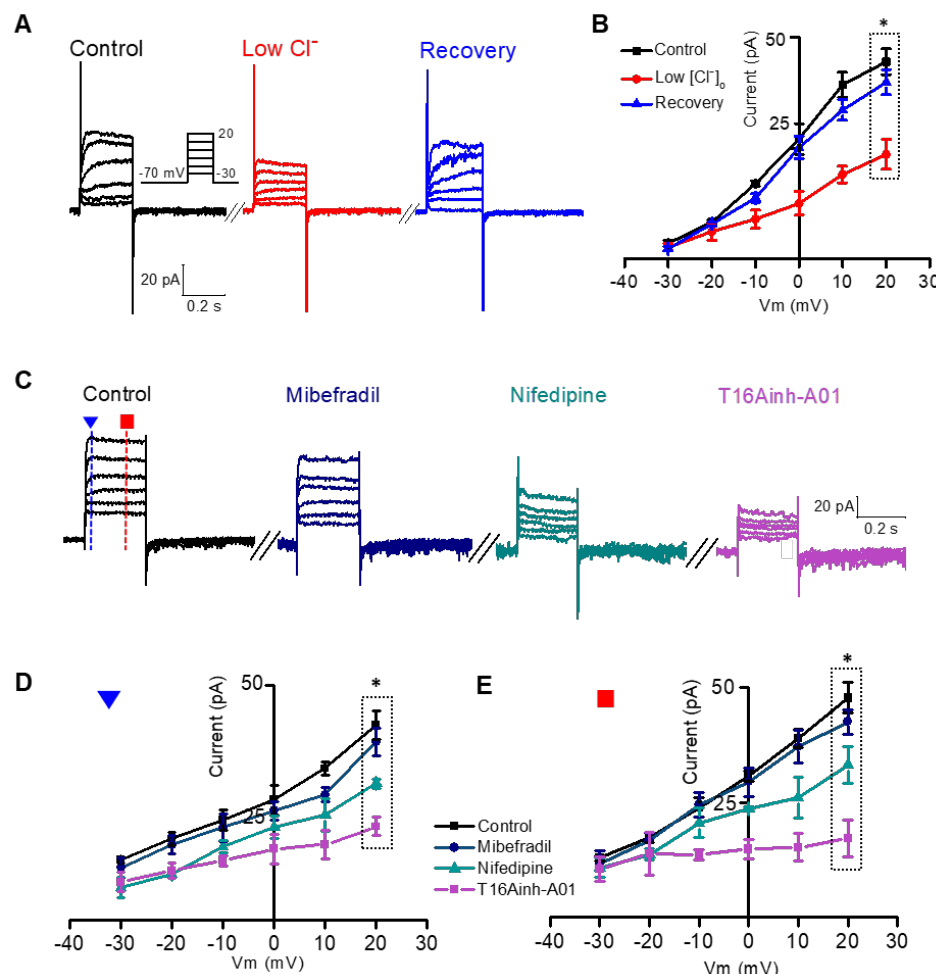
Figure 2. Isolation of the voltage-dependent component of ANO1 in rod bipolar cells. Isolation of the outwardly rectifying ANO1 component with strong voltage dependence. ( A ) In a single rod bipolar cell lacking I tail , a family of whole-cell currents was serially recorded to monitor the changes in outward current as [Cl − ] o changes. First, voltage-clamp (−30 to 20 mV for 250 ms) was performed under 140 mM of [Cl − ] o (black). Next, a family of whole-cell current was recorded after the extracellular replacement of Cl − with 100 mM gluconate (red) and then back to the control (blue). ( B ) For each of the three cases, the outward current (mean amplitudes measured at 200 ms after the onset of the depolarizing pulse) was plotted against the command voltage ( n = 7, * p < 0.05, ANOVA). ( C ) The effects of VGCC inhibitors and ANO1-specific blocker on outward rectifying currents were plotted by recording a series of whole-cell currents. The control (black), 10 µ M mibefradil (navy), 30 µ M nifedipine (dark cyan), and 10 µ M T16Ainh-A01 (violet) were administered in this order to the cells in bath while waiting for recovery before administration. To compare the changes in the earlier portion (blue triangle) and in the later portion (red rectangle), the amplitudes measured at 20 and 200 ms after the onset of the depolarizing pulse were plotted in ( D ) and ( E ) against the command voltage, respectively. The inhibitors significantly reduced outward currents, compared to the control ( n = 6, * p < 0.05,